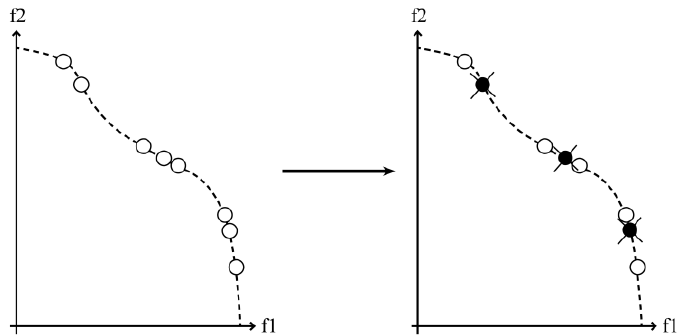
Figure 10. Environmental selection process.